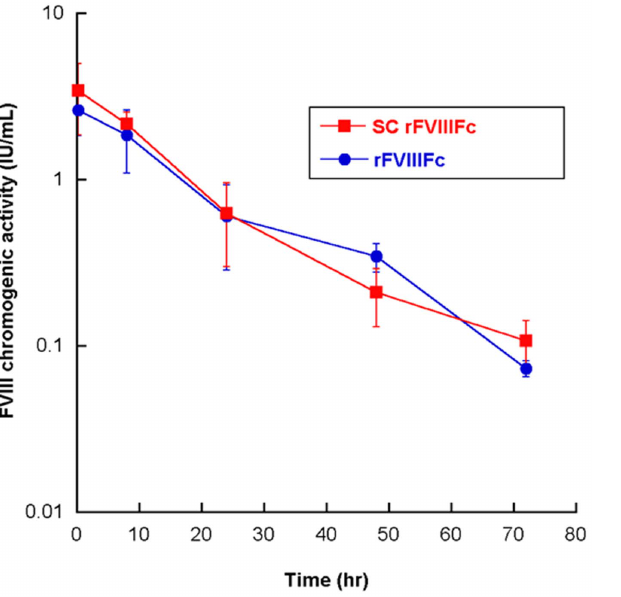
Figure 5. PK profiles of SC rFVIIIFc and rFVIIIFc in HemA mice (single dose 250 IU/kg). Results shown are mean ¡ SD from 4 mice per treatment at each time point. The PK parameter estimates are summarized in Table 4.